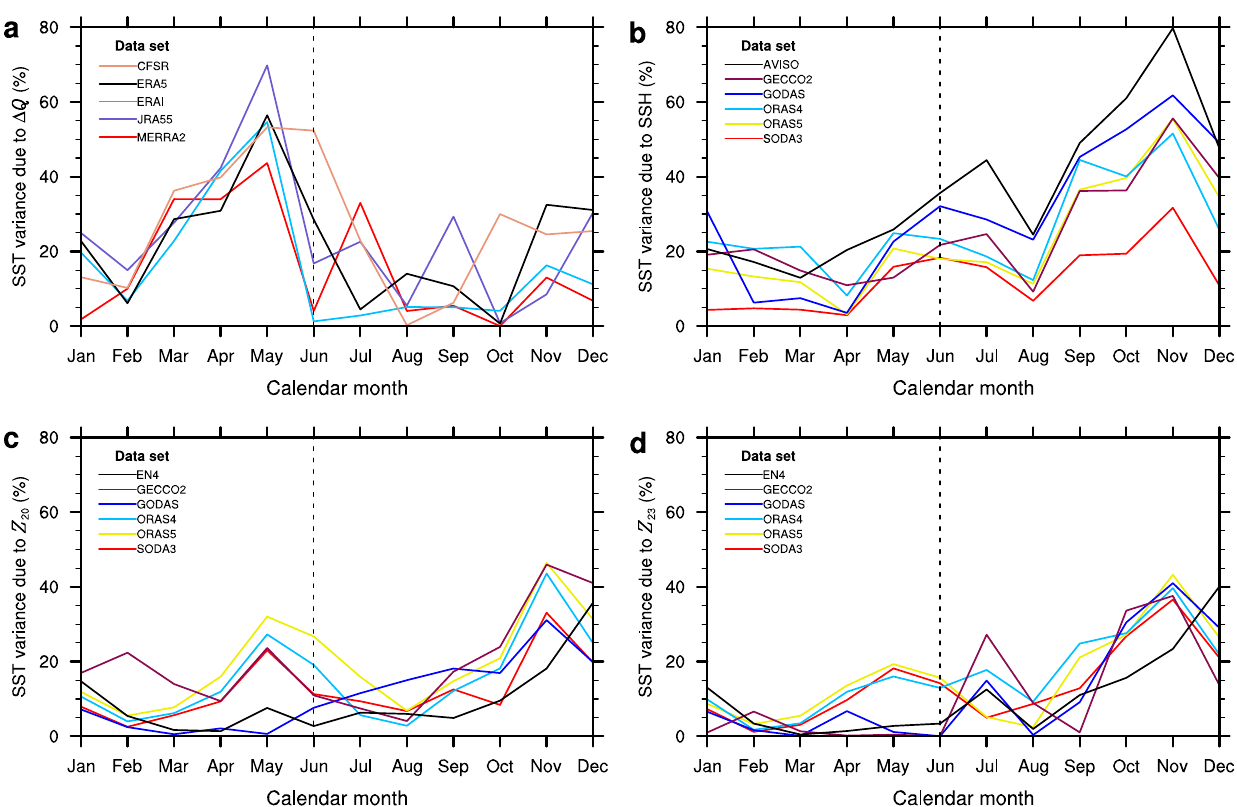
Fig. 2 Sea surface temperature explained variances. The explained variances were estimated from r 2 and expressed as percentages: where r is the correlation between the seasonally strati fi ed Atl3 SST (that is, average in the region 3°N – 3°S, 0° – 20°W) and a diabatic-heating gradient ( Δ Q ), b sea surface height (SSH), c 20 °C isotherm depth ( Z 20 ) and d 23 °C isotherm depth ( Z 23 ) averaged over the equatorial Atlantic (3°N – 3°S, 5°E –